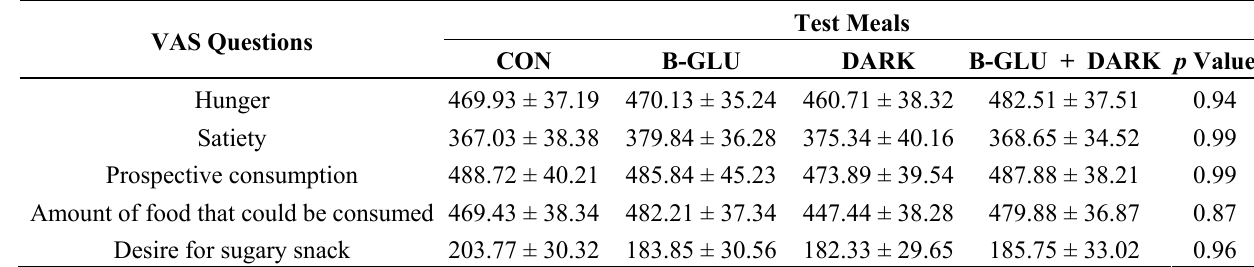
Table 2. AUC data of VAS scores.